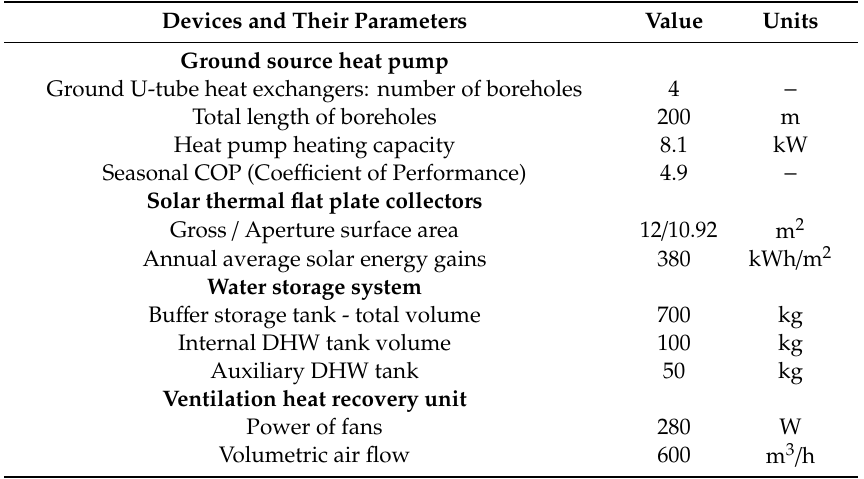
Table 1. Main (elements) devices of the heating system of the house and their main parameters. Devices and Their